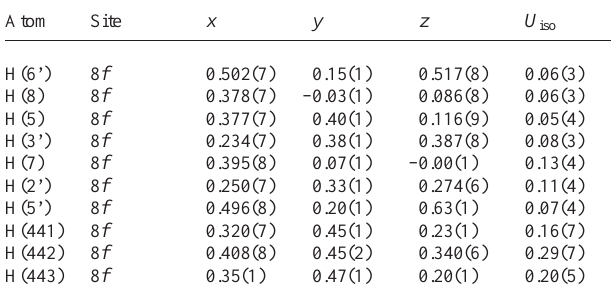
Table 2. Atomic coordinates and displacement parameters (in Å 2 )